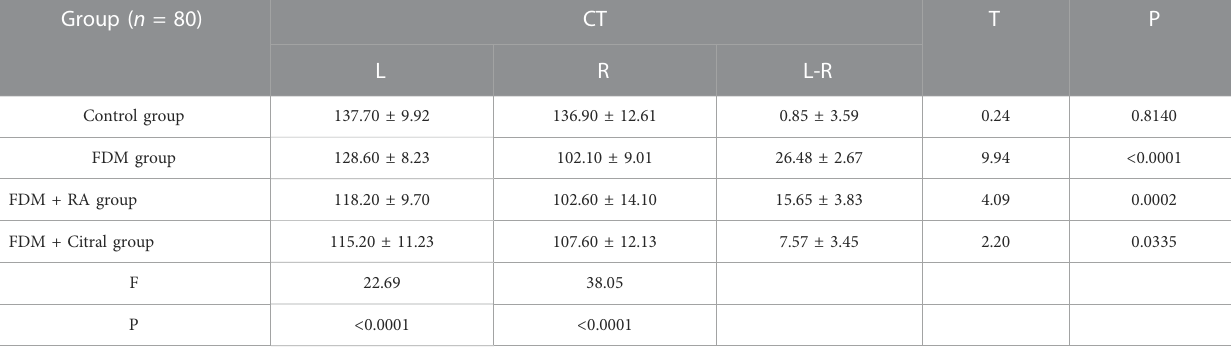
TABLE 4 CT results of left and right eyes of guinea pigs in each group measured by EDI-OCT ( μ m). Group ( n = 80) CT T P L